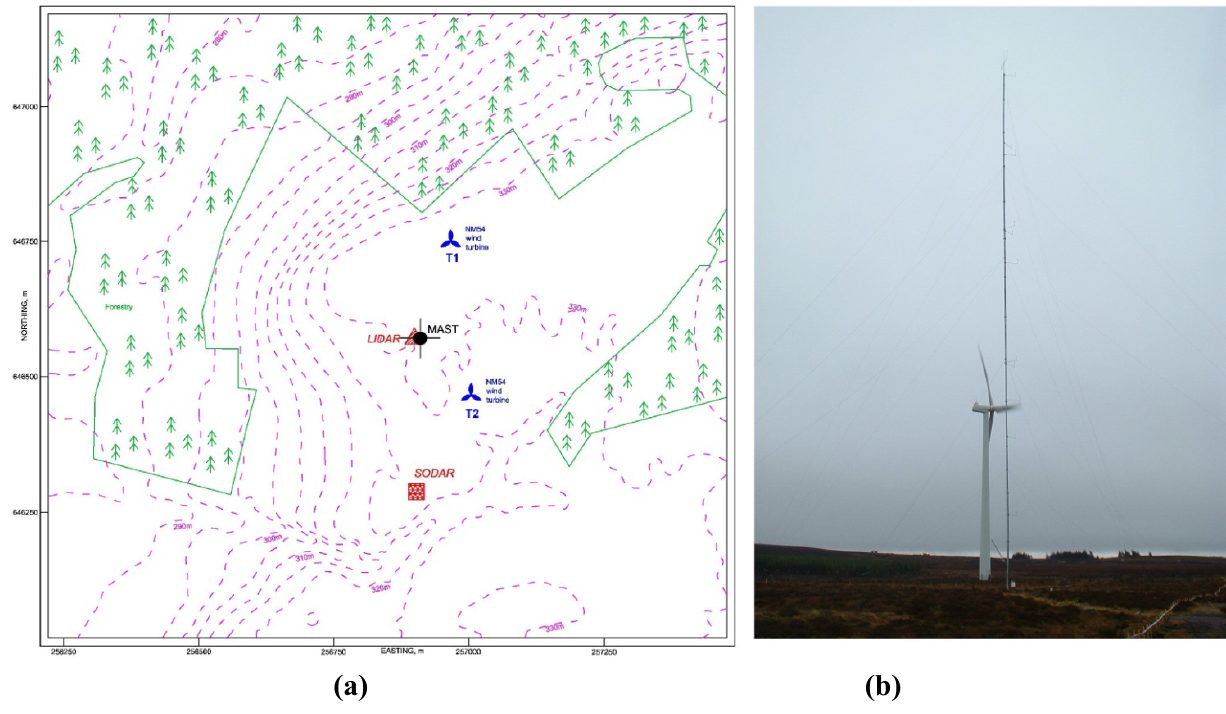
Figure 1. (a) Site layout plan; and (b) photograph of 80 m instrumented mast (view from northwest, with southeastern wind turbine, T2, in the